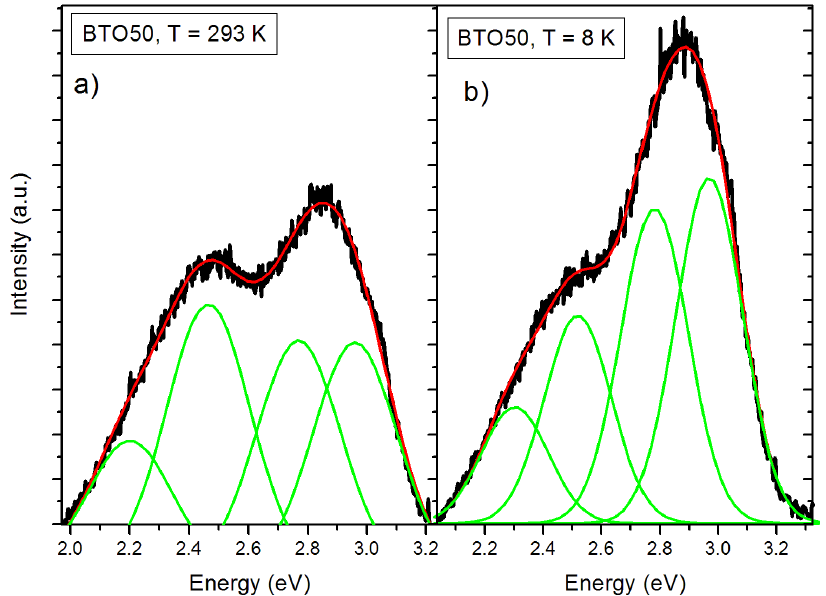
Figure 4. Fitted photoluminescence (PL) spectrum of BTO50 at 293 K ( a ) and 8 K ( b ) showing bandgap of 3.0 eV and the complex visible band composed of emissions at 2.2, 2.5 and 2.7 eV.